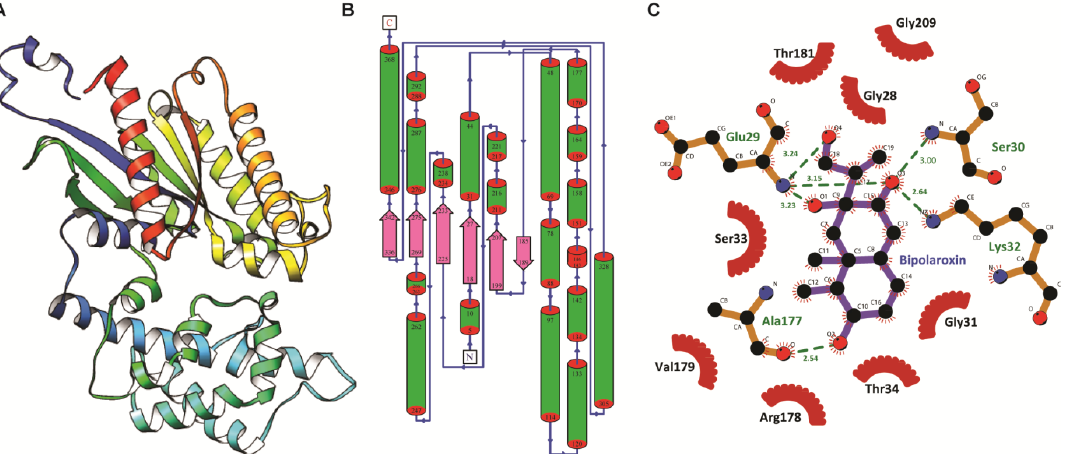
Figure 1. Three-dimensional model and 2D representation of the interaction between Biopolaroxin and G-Alpha subunit. ( A ) The solid ribbon representation of three-dimensional architecture of modeled G alpha subunit of wheat with domains (helical: lower half and Ras domain: upper half). ( B ) The topology of architecture of the modeled structure where the position of each helix and strand has been labeled from N-terminal end to c-terminal end. ( C ) Molecular representation of the top-ranked docked complex obtained from molecular docking of G-alpha subunit with Bipolaroxin rendered using LigPlot + tool. The green dotted lines show the hydrogen bonds, residues with dark-red semicircles forming hydrophobic contacts, and residues labeled in green portray the H-bond forming amino acids.